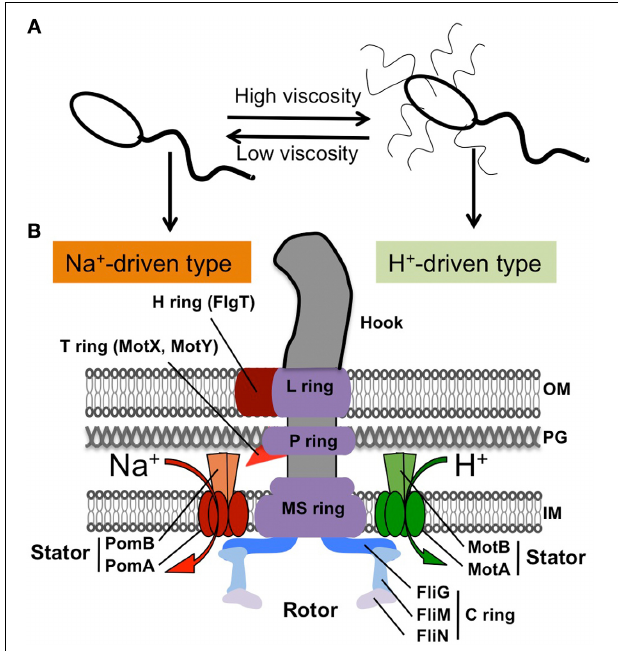
FIGURE 1 | Flagellar structure of Vibrio . (A) Polar flagellum and lateral flagella in some Vibrio species (not including Vibrio cholerae ). (B) Schematic diagram of the hook basal body for a polar flagellum shown in the left half (based on EM images, (Terashima et al., 2006, 2013)) and the lateral flagellar structure shown in the right half, according to the peritrichous flagellum from Salmonella (MacNab, 2003). The characteristics of the polar flagellum are the H ring and the T ring, shown in